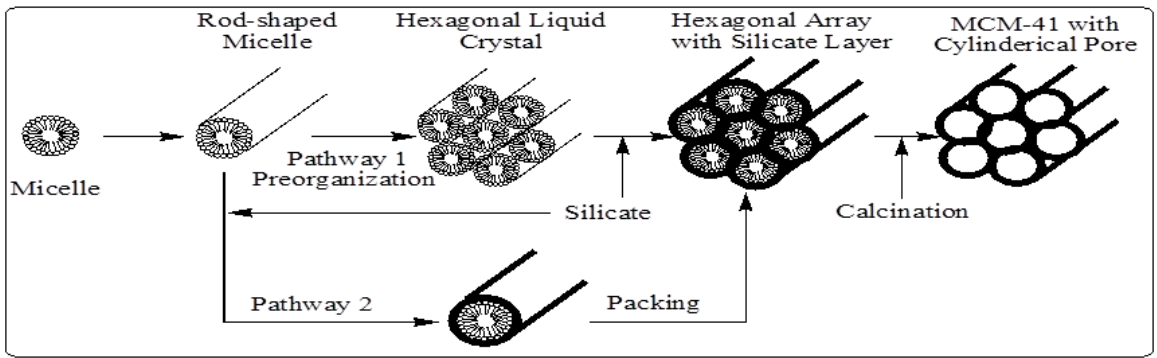
Figure 6. Schematic model of liquid crystal templating mechanism via two possible pathways